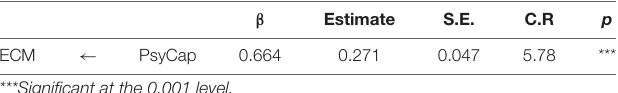
TABLE 4 | The relationship between PsyCap and ESL classroom management.